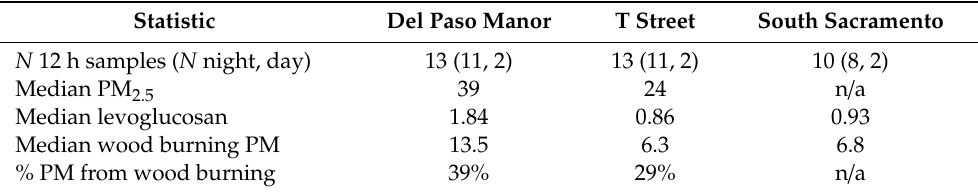
Table 3. Summary of filter results ( µ g / m 3 ) by site; Del Paso Manor and T Street are non-EJ and South Sacramento is an EJ